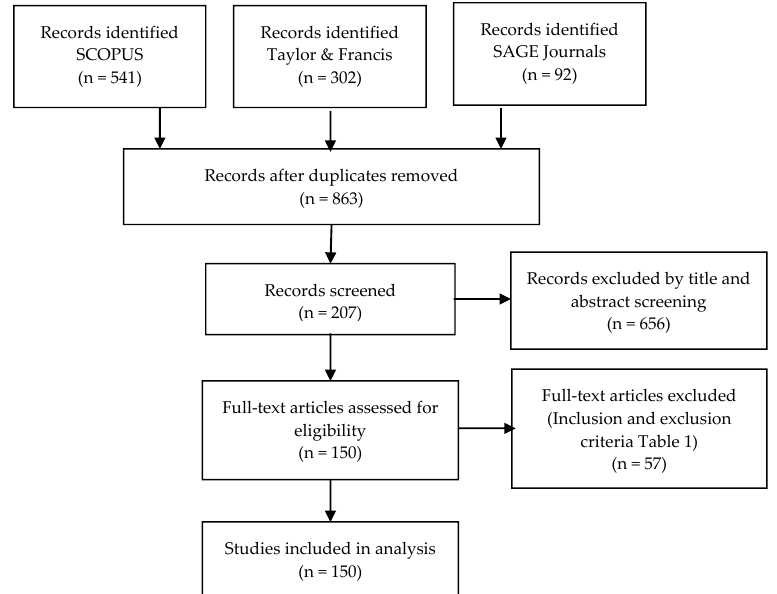
Figure 1. PRISMA flow diagram [18] for the systematic literature review about information and communication technologies (ICT)-mediated assessment.